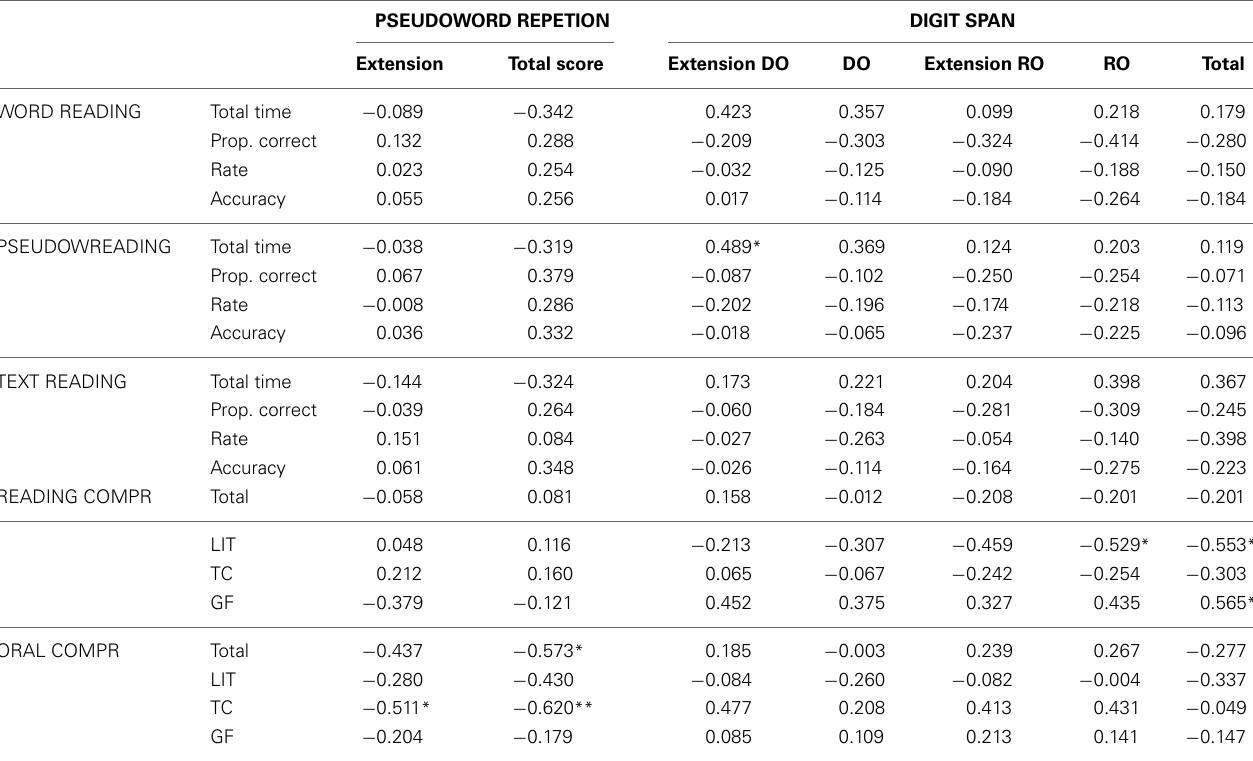
Table 5 | Correlations between variables—Group with